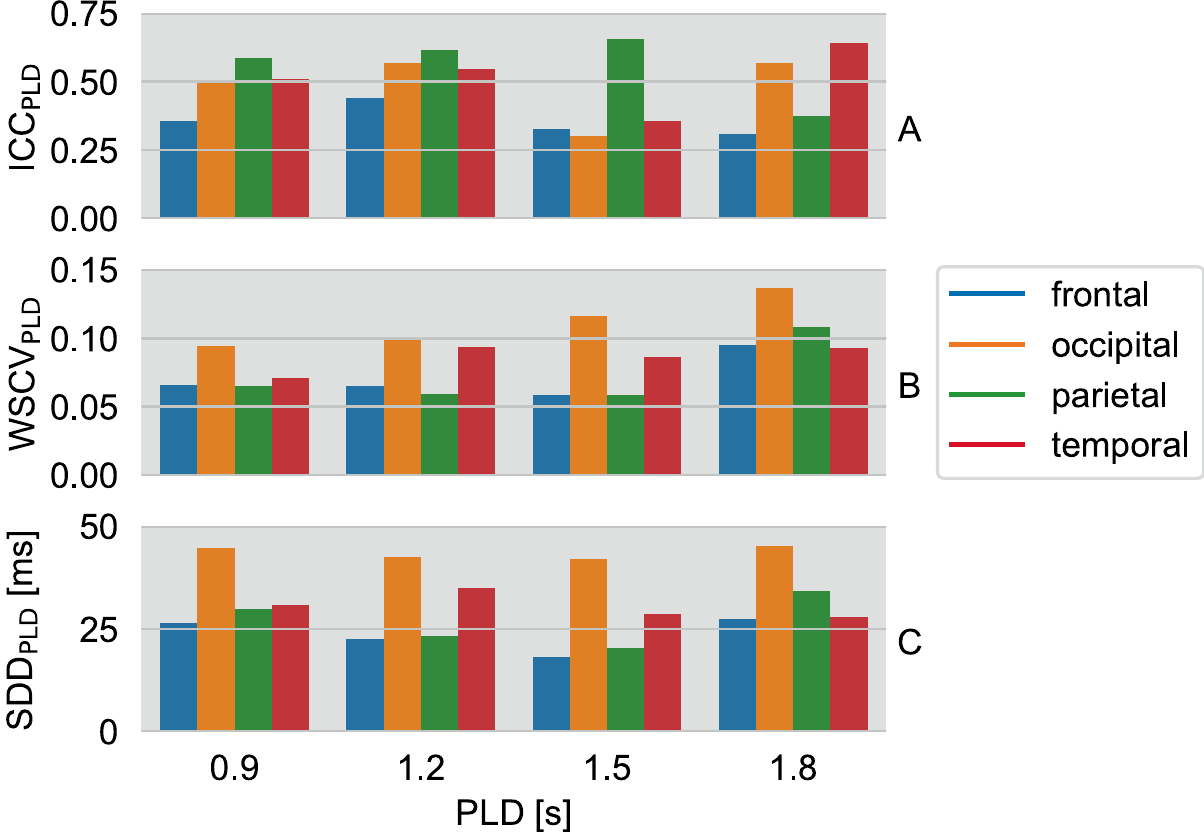
Figure 4. ( A ) Intraclass correlation coefficient ICC PLD , ( B ) within-subject coefficient of variation WSCV PLD and ( C ) smallest detectable difference SDD PLD of median T 2 values from repeated measurements of ten subjects. Results are shown for four postlabeling delays PLD = 0.9/1.2/1.5/1.8 s and four gray matter regions of interest